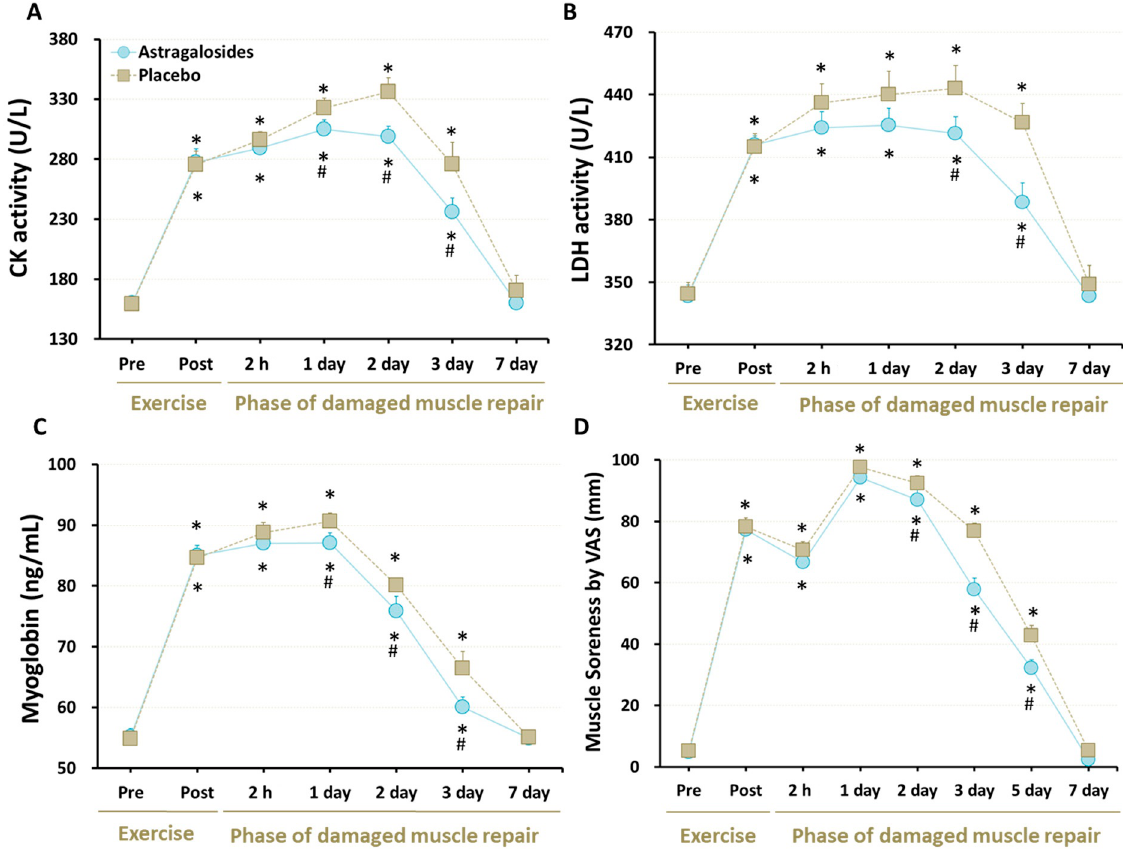
Figure 2. Effect of astragalosides supplementation on muscle-damage markers. ( A ) Serum creatine kinase (CK) activity; ( B ) serum lactate dehydrogenase (LDH) activities; ( C ) serum myoglobin levels; ( D ) muscle soreness. The levels of creatine kinase activity, lactate dehydrogenase activity, and myoglobin were measured before and after eccentric exercise, and at 2 hr, and 1, 2, 3, and 7 days of the recovery period. The subjects’ severity of quadriceps femoris muscle pain was assessed before and after eccentric knee-extension exercise, and at 2 h, and 1, 2, 3, 5, and 7 days of the recovery period. Values are expressed as means ± SD ( n =11). * p < 0.05 vs. pre-exercise for the same group. # p < 0.05 vs. placebo for the same time.